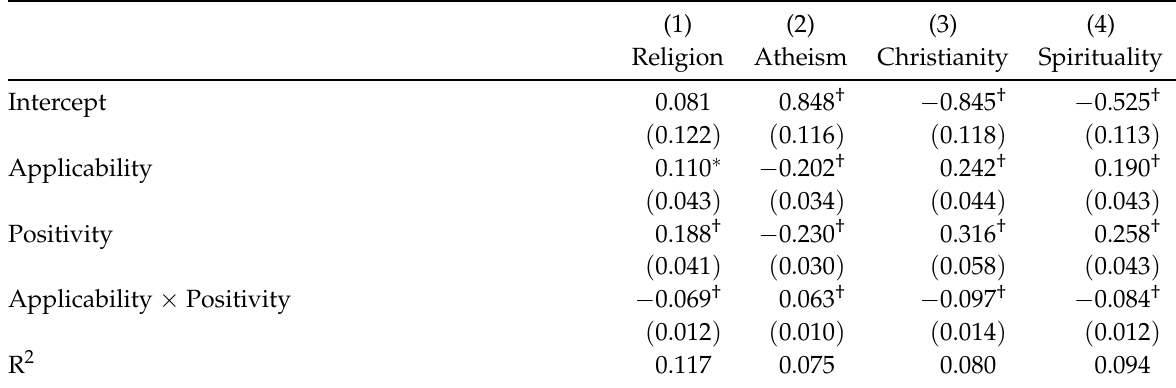
Table 4: Evangelicals: OLS regression estimates of difference of natural log of response time to natural log of average response